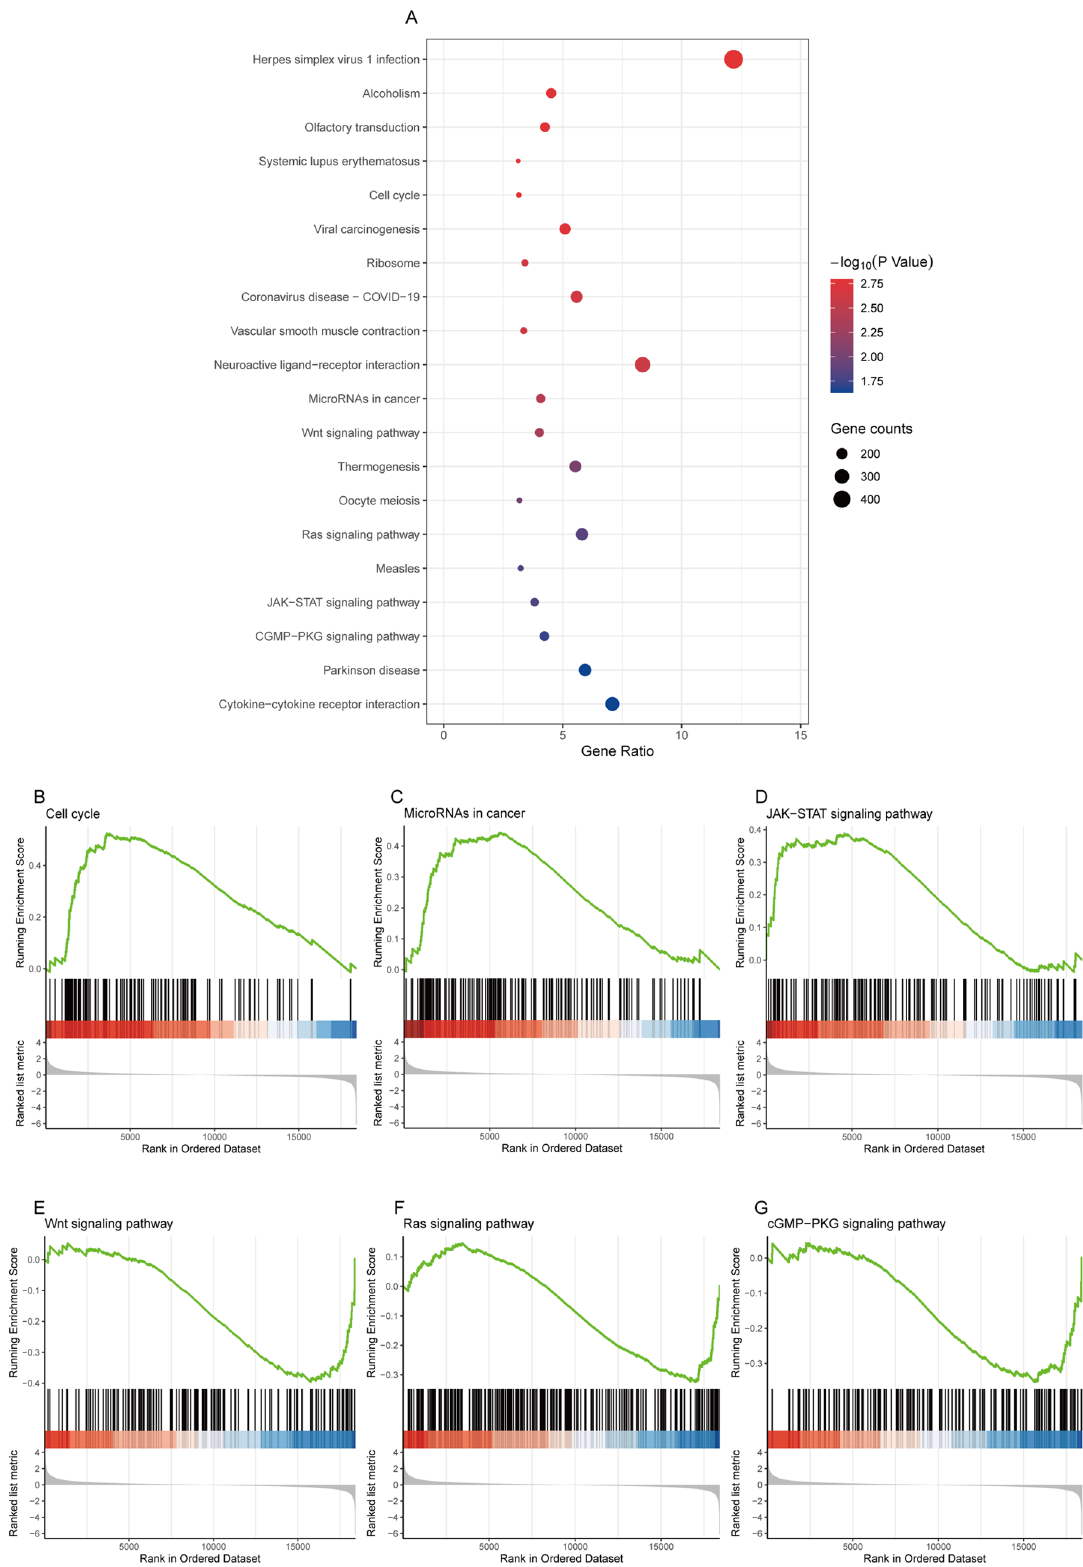
Figure 5. Functional enrichment of GREB1L in LUAD. ( A ) GSEA pathway enrichment analysis of differentially expressed genes (DEGs) in low- and high- GREB1L expression samples; ( B – G ) Enrichment of genes in the Cell cycle, MicroRNAs in cancer, JAK- STAT signaling pathway, Wnt signaling pathway, Ras signaling pathway, and cGMP- PKG signaling pathway by GSEA pathway